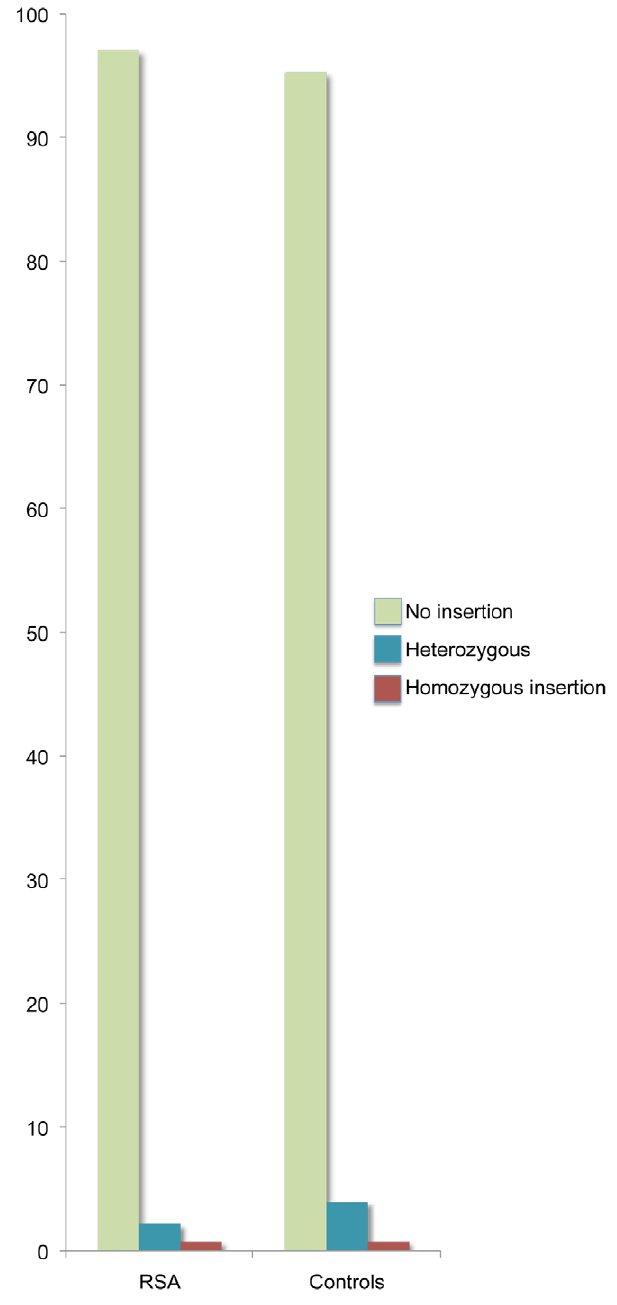
Figure 2. Genotype distribution of PROGINS insertion; (T1) wild type (no insertion) and (T2) insertion